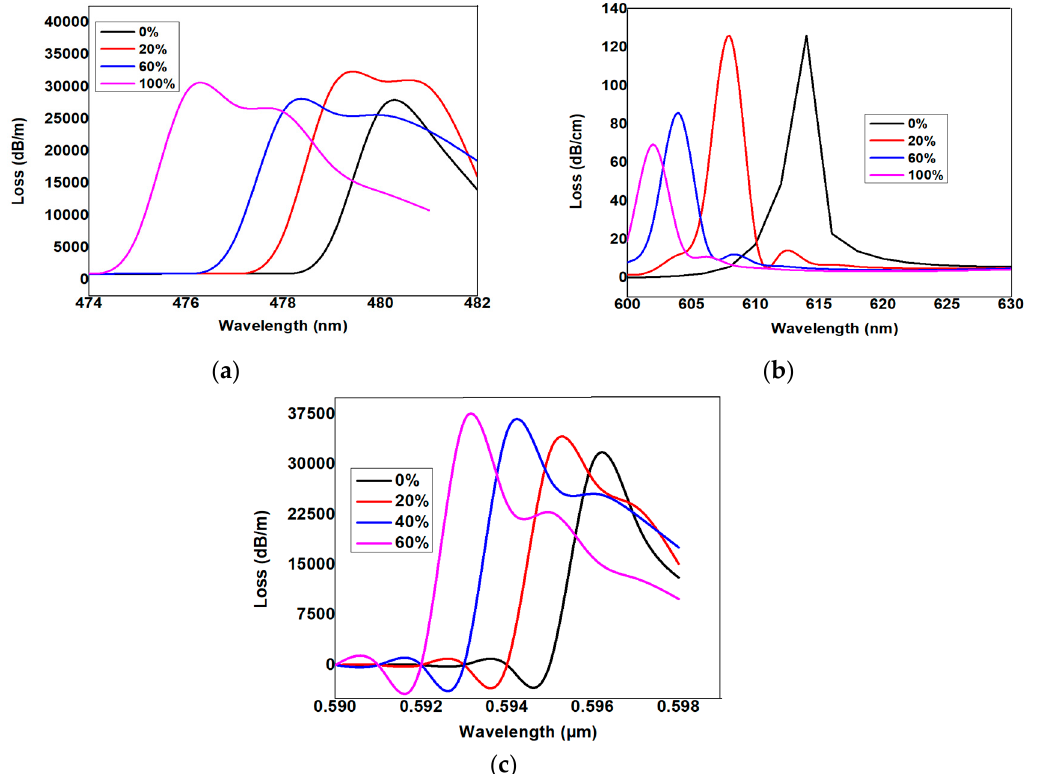
Figure 3. ( a ) Loss spectra versus wavelength with respect to the variation of the alcohol concentration keeping Ag as 30 nm. ( b ) Loss spectra versus wavelength with respect to the variation of the alcohol concentration keeping Cu as 10 nm. ( c ) Loss spectra versus wavelength with respect to the variation of the alcohol concentration keeping Ag and Cu thickness as 30 nm and 10 nm, respectively.